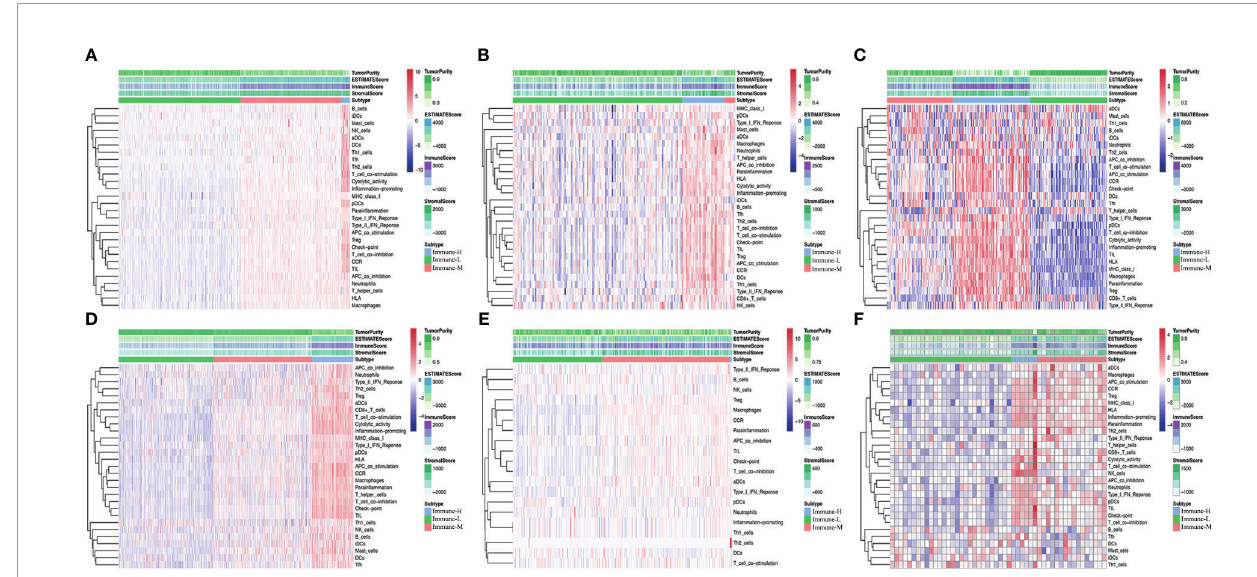
FIGURE 1 | Immune phenotype classi fi cation and four glioma immune microenvironment signatures identi fi cation. (A – F) Heatmaps showing three immune phenotypes, tumor purity, ESTIMATE, immune and stromal scores in the glioma microenvironment of samples from the TCGA microarray, TCGA GBM RNA-seq, CGGA microarray, CGGA RNA-seq, GSE16011, and GSE43378